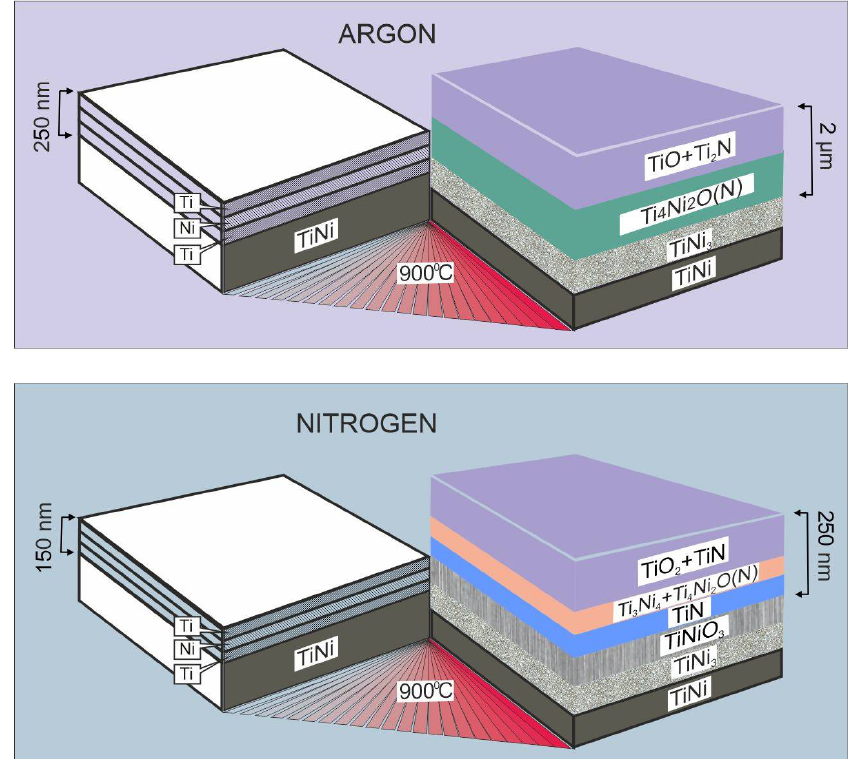
Figure 6. Scheme of the structure and phase composition of the coating obtained in argon and nitrogen atmospheres.